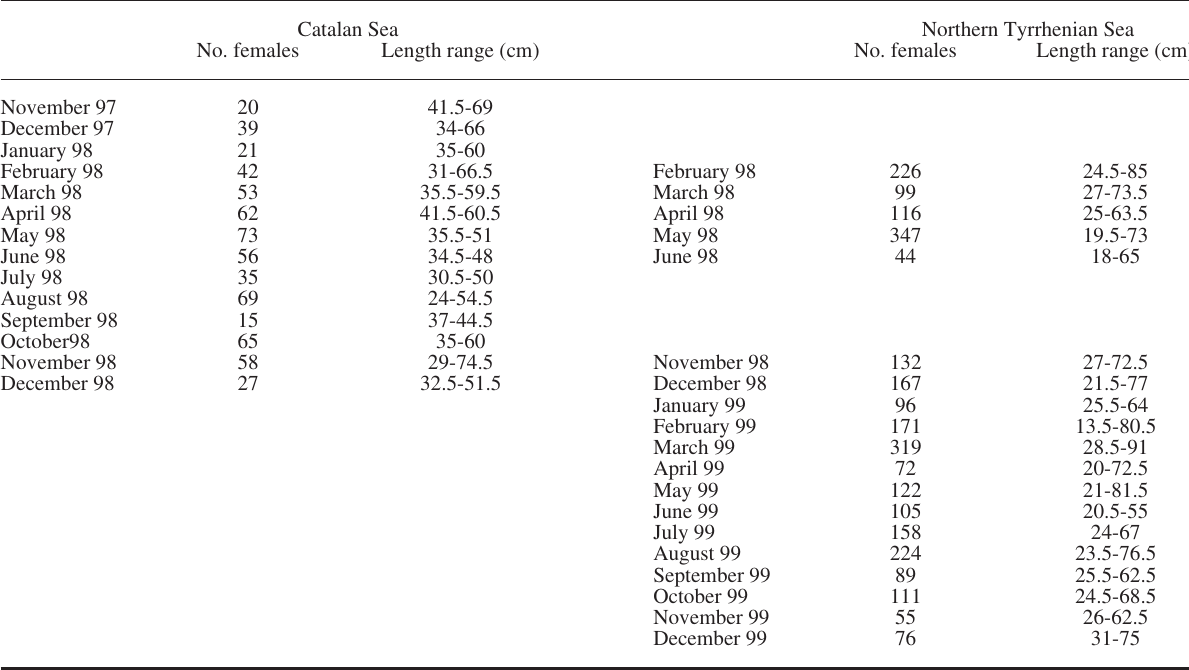
Table 1. – Sampling data on M. merluccius females in the Catalan Sea and northern Tyrrhenian Sea. Catalan Sea Northern Tyrrhenian Sea No. females Length range